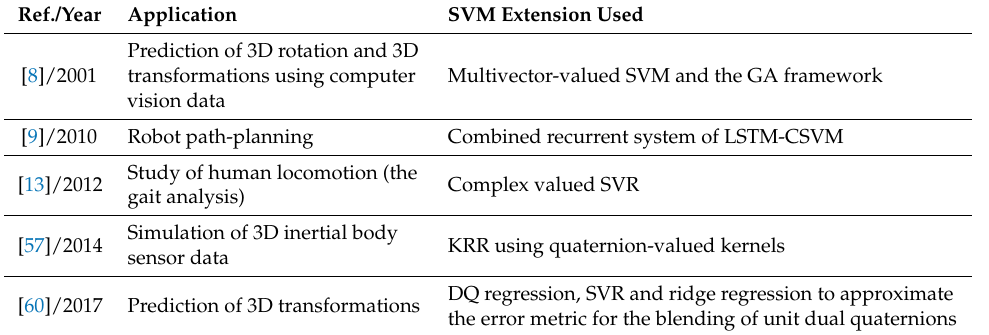
Table 6. Applications of complex and hypercomplex SVMs for robotics and computer vision